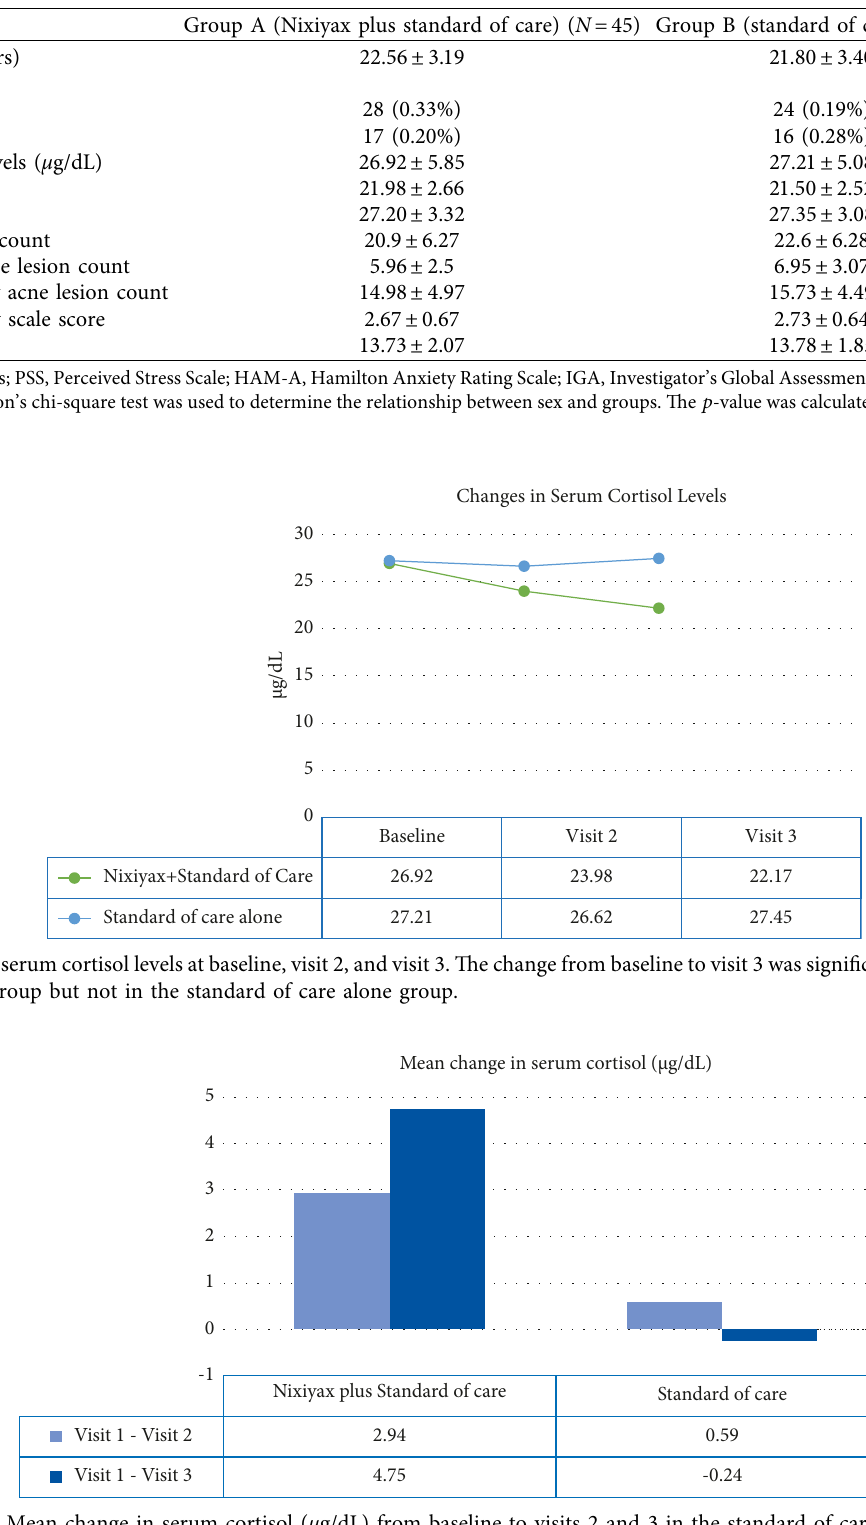
Table 1: Baseline characteristics.